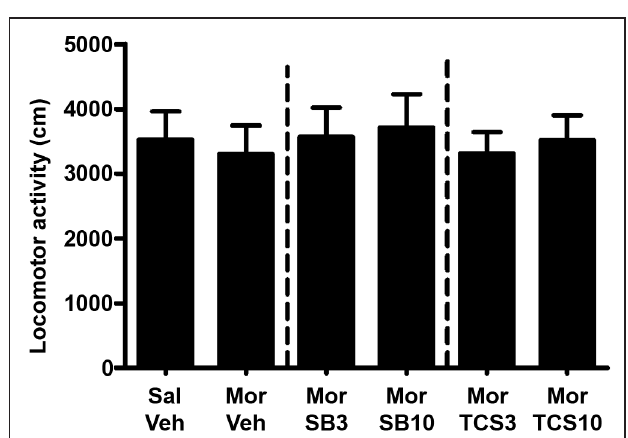
FIGURE 4 | Mean locomotor activity of all the groups in experiment 1. All data are expressed as mean ± SEM.